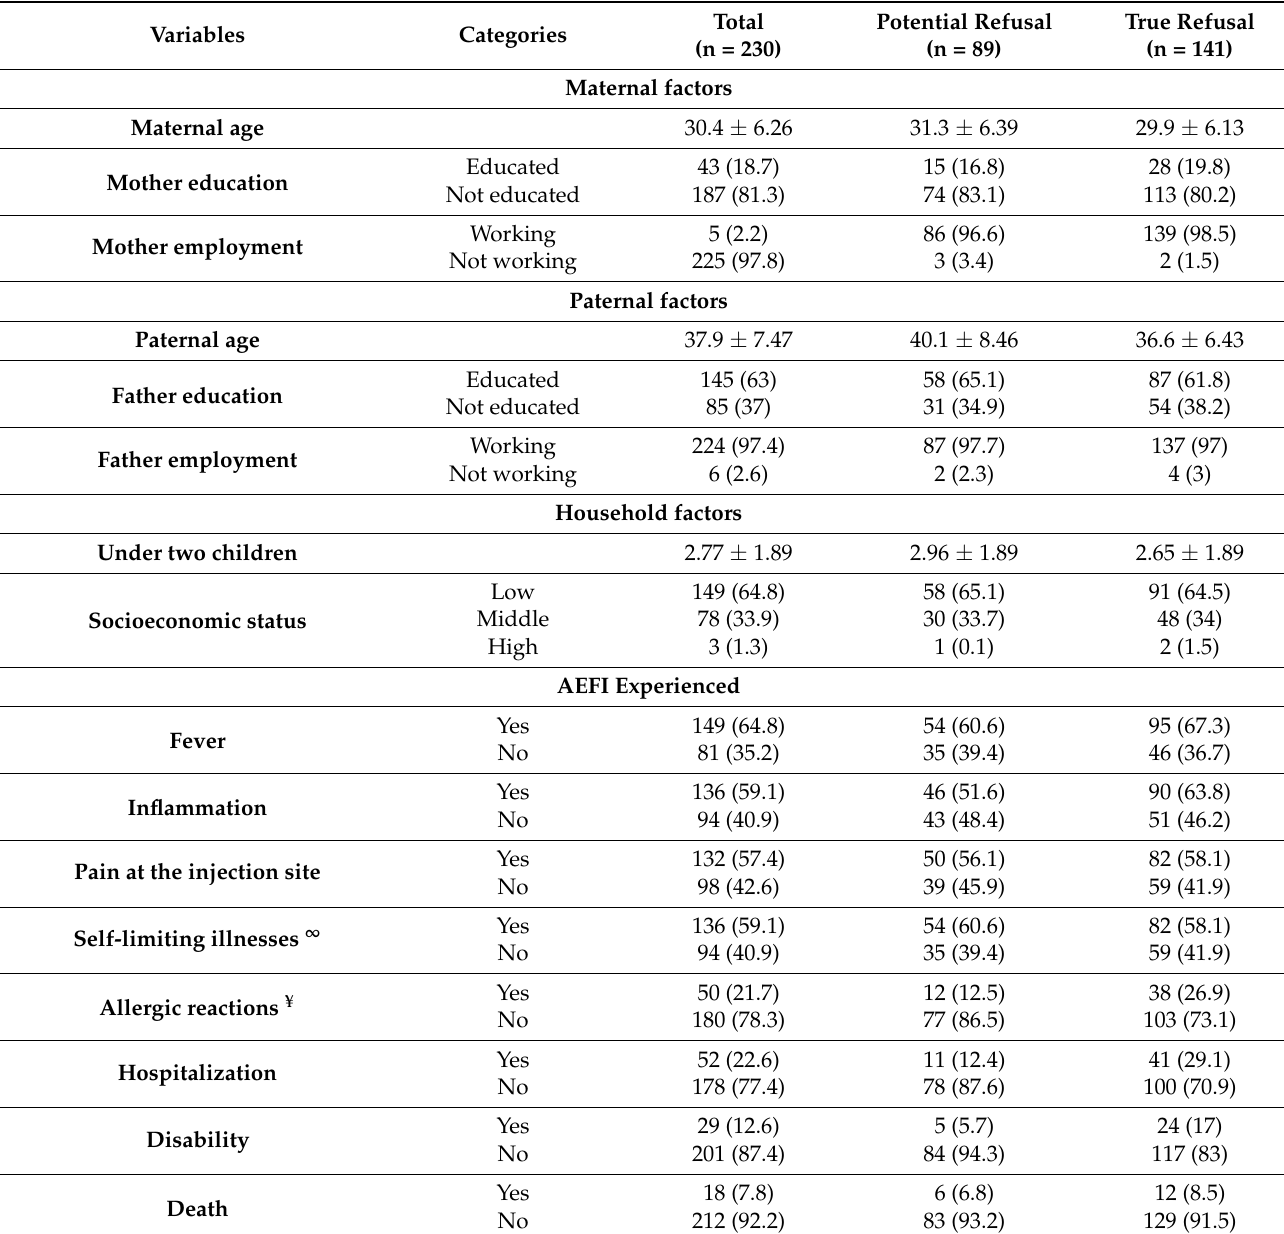
Table 1. Characteristics of parents/caregivers of children who refused vaccination (n =